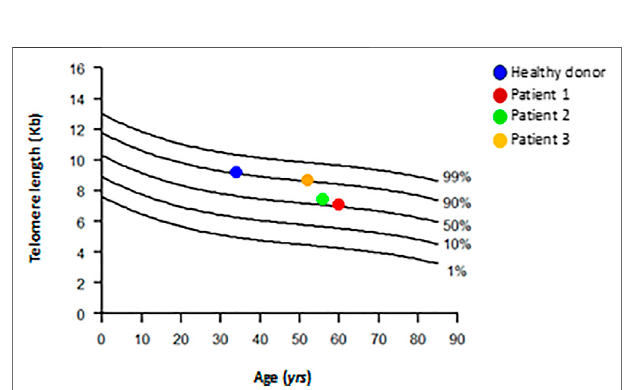
FIGURE 6 | Distribution of age-matched telomere length in DNA from healthy subjects leukocytes and DNA from healthy subject and patients ’ MSCs.Healthysubjects( n =261)arerepresentedasline;MSCsfrompatients and one healthy control are represented as colored circles. Telomere length is given as kilobases (kb) by Southern blot.